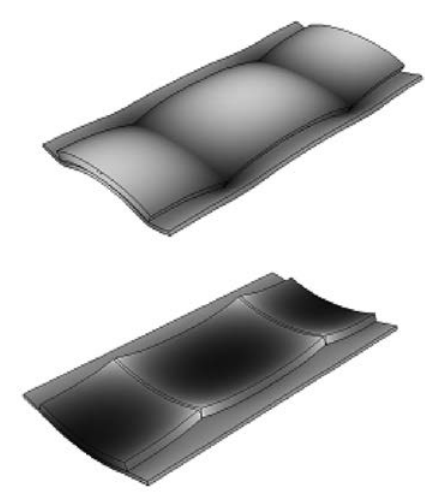
Fig 1. Curling of concrete pavement: a – downward curling;